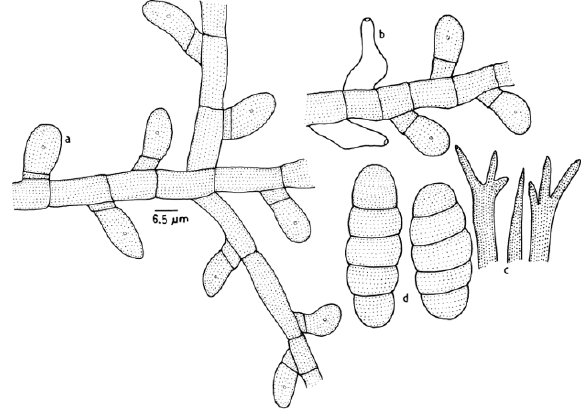
Figure 51. Meliola butleri a - Appressorium; b - Phialide; c - Apical portion of mycelial setae;